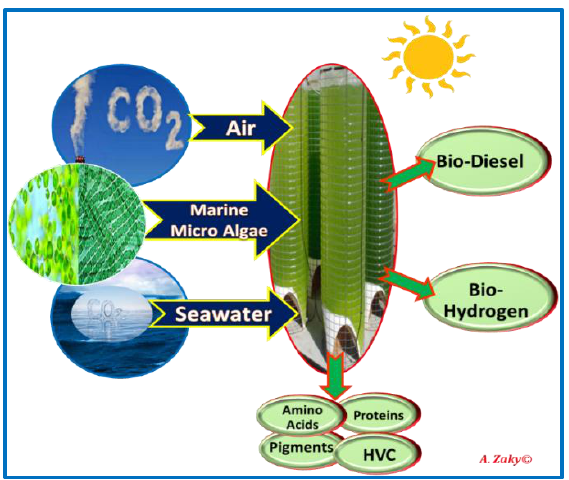
Figure 5. CMB system for the production of biodiesel and/or biohydrogen (Route 3).